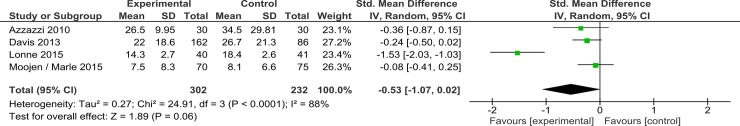
Comparison II (device versus decompressive surgery interventions), outcome overall functional status.Meta-analysis revealed no significant difference between groups and high heterogeneity.